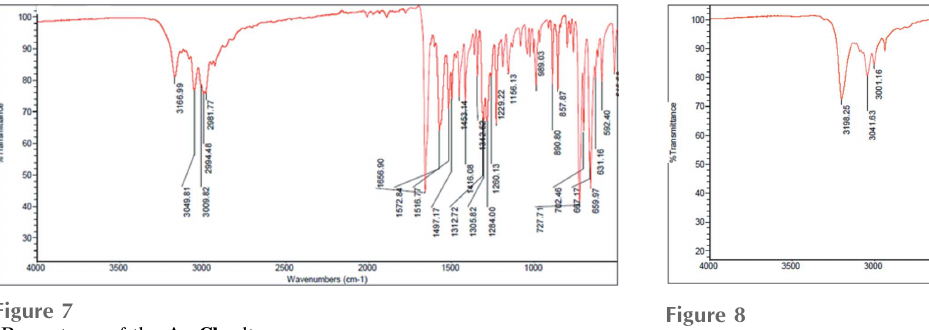
Figure 8 IR spectrum of the AmBr